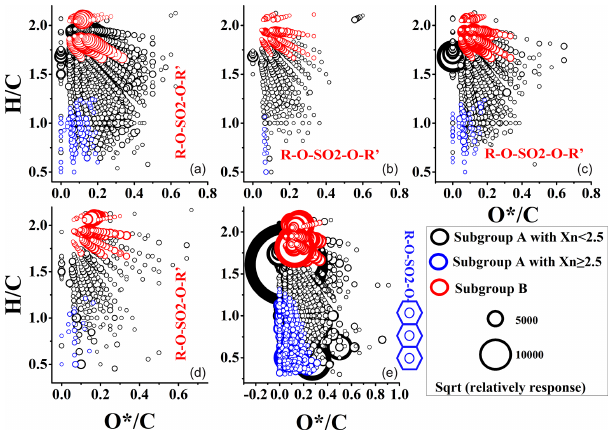
Figure 5. The ratios of O ∗ / C vs. H / C of CHOS and proportion of the subgroup B and Xn>2.5 for off-road engines. Panels (a), (b), (c), (d) , and (e) are the mass spectra for excavators in the idling, working, and moving modes and vessels using diesel and HFO, re-